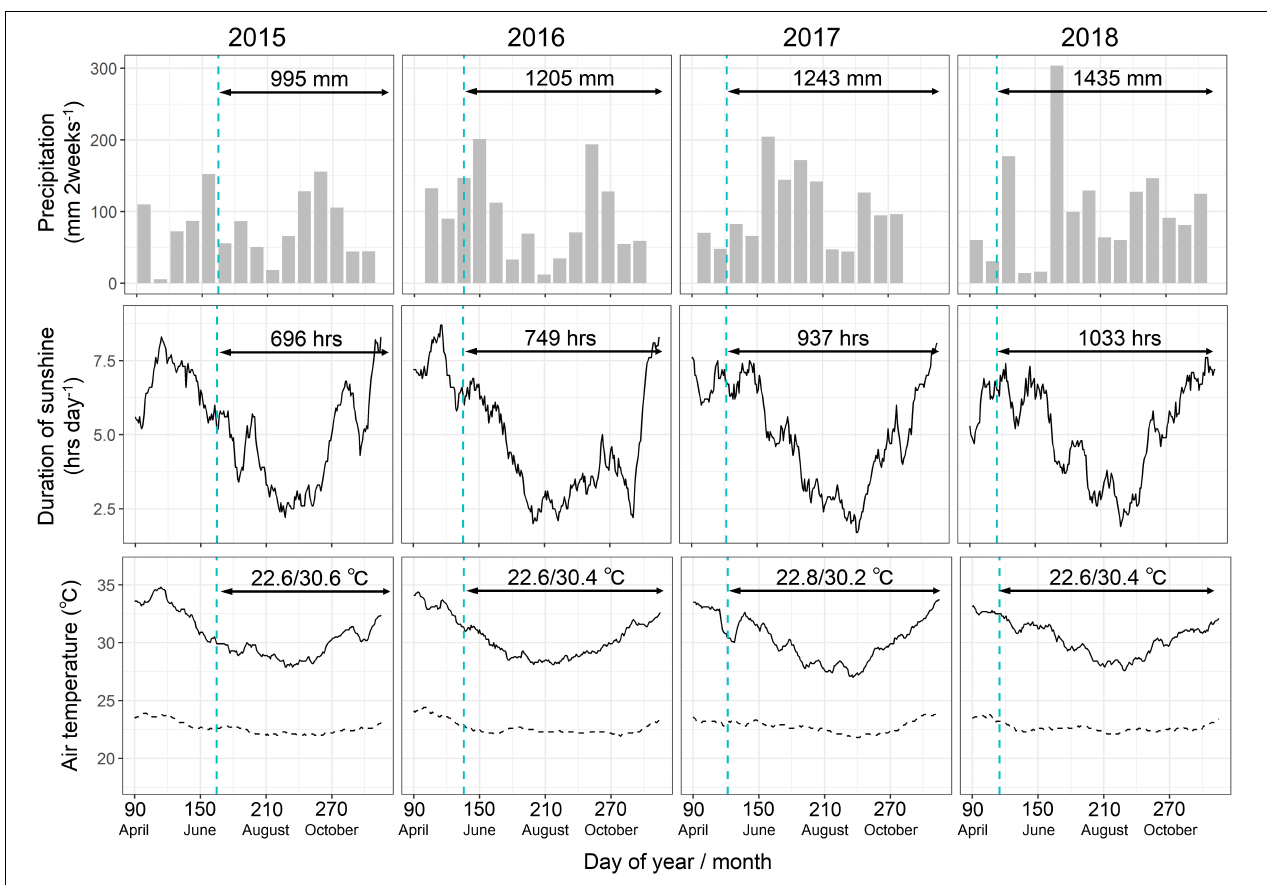
FIGURE 1 | Meteorological conditions during the experimental period. The precipitation, duration of light, and air temperatures are separately shown for all the years. Arrows indicate the plant growth periods in each year. Numbers with the arrows represent total precipitation (mm), total duration of light (hours), and average maximum/minimum temperatures ( ◦ C) during the plant growth periods. Vertical dashed lines represent the planting date of each